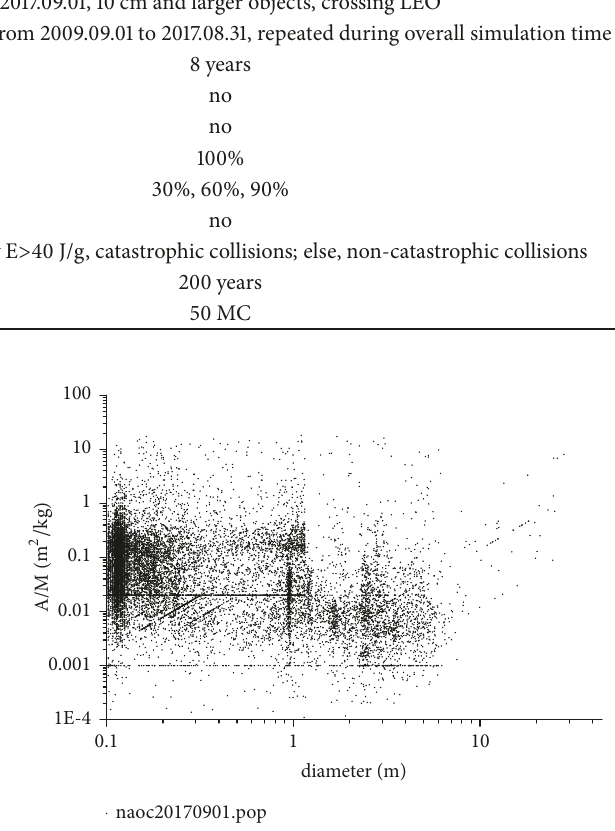
Figure 6: The semimajor axis versus eccentricity distribution of population data of 2017.09.01. Figure 7: The A/M versus size distribution of population data of